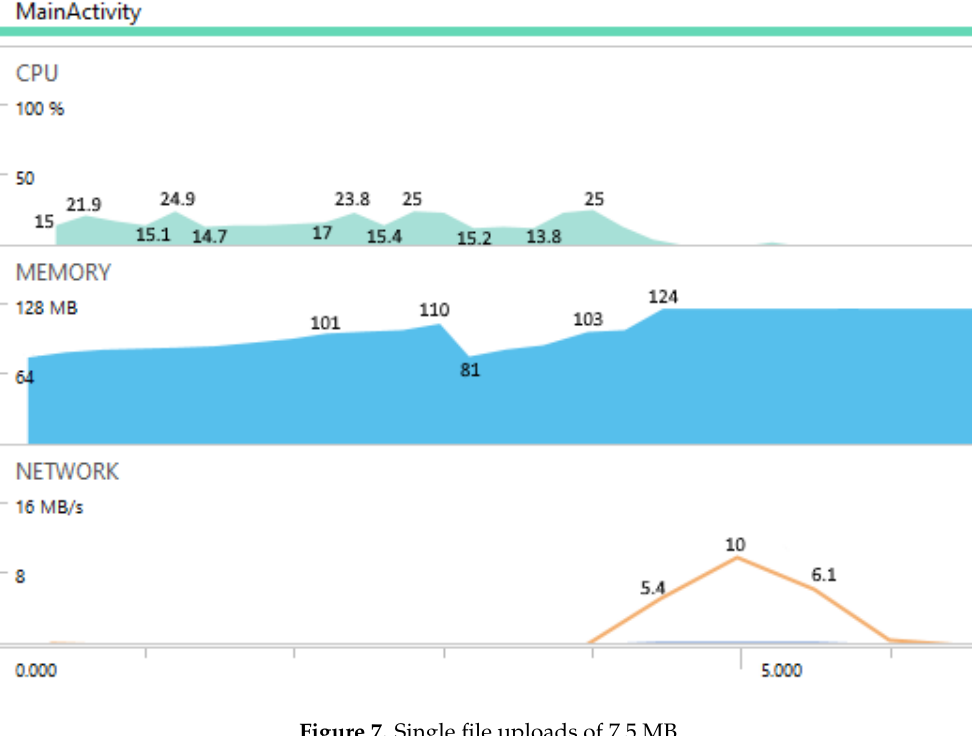
Figure 7. Single file uploads of 7.5